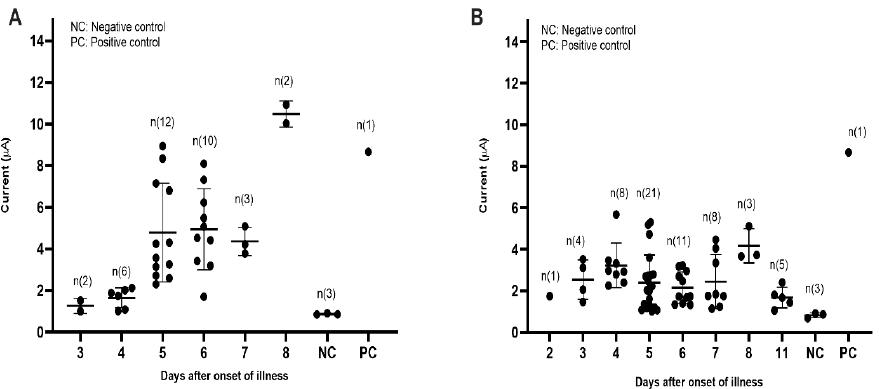
Figure 7. Diagnostic evaluation of the dengue IgM electrochemical biosensor using dengue positive sera. ( A ) The electrochemical response generated from sera with primary dengue. ( B ) The electrochemical response generated from sera with secondary dengue.